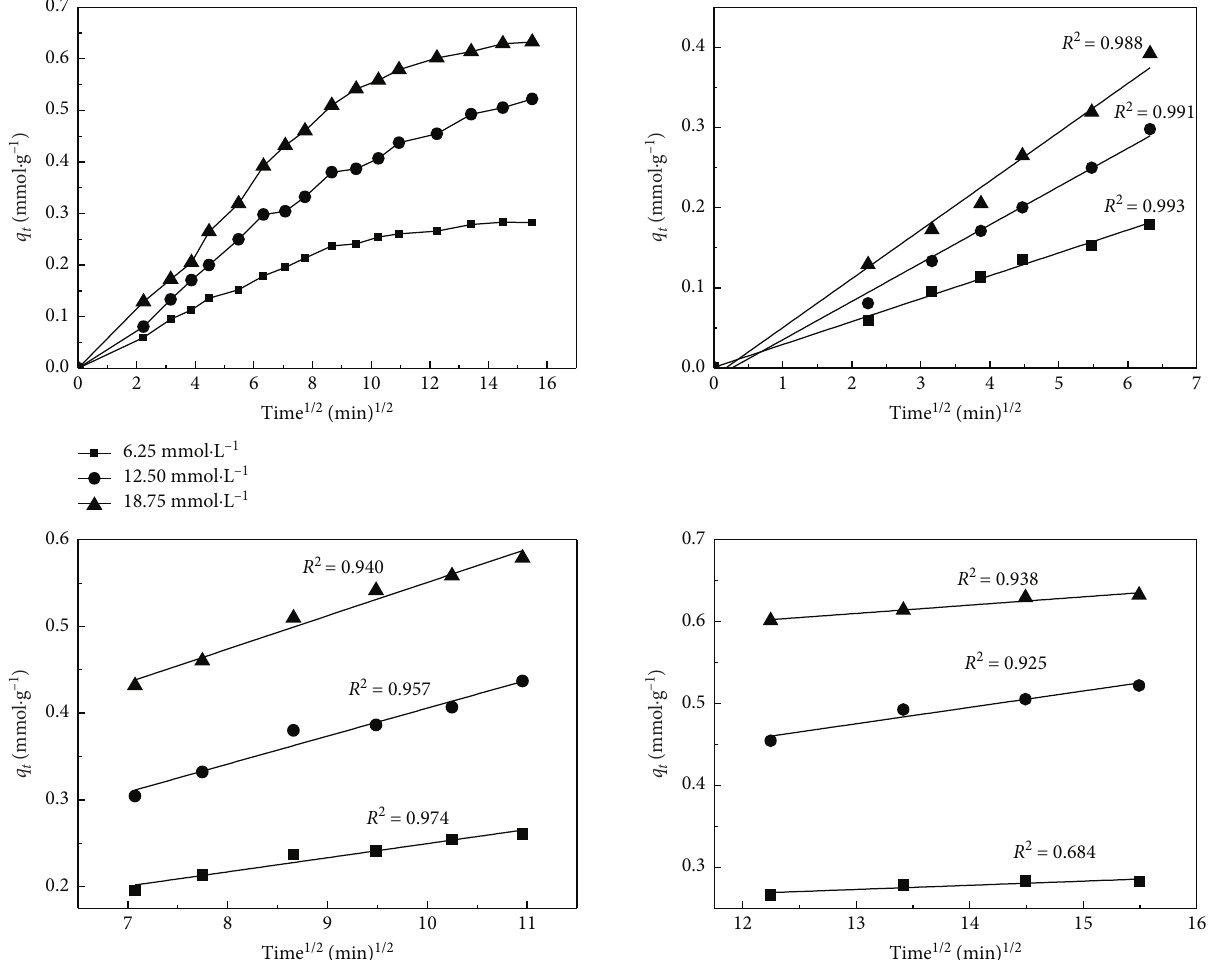
0 , 20mL; adsorbents, 0.2g 2wt. % Mn/